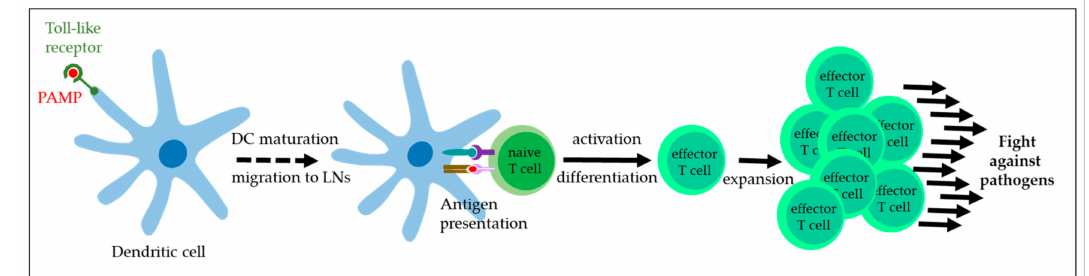
Figure 2. Role of Toll-like receptors in T cell activation. Recognition of PAMPs by TLRs expressed by dendritic cells (DCs) leads to maturation of these antigen-presenting cells and their migration to draining lymph nodes. In the presence of co-stimulatory molecules, DCs present antigens via MHC molecules to naive T cells. Upon this stimulus, naive T cells differentiate into effector T cells that expand, move to the site of infection, and fight the invading pathogens